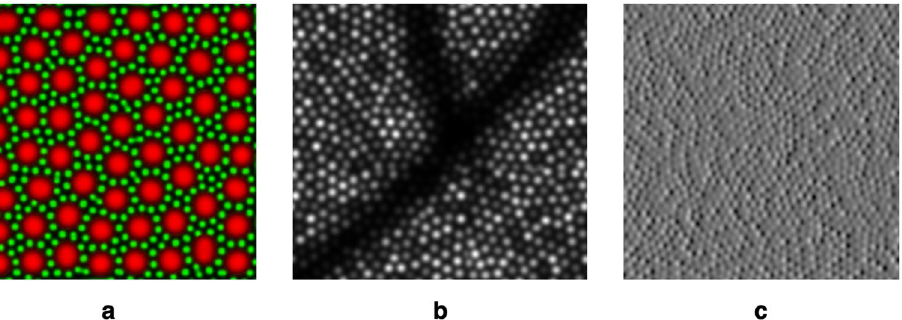
Figure 5. Examples to show possible extensions to ERICA. Panel ( a ) shows the output of a reaction-diffusion model that includes a rod mosaic (shown in green), self-organising itself between cone cells (shown in red). Panel ( b ) shows simulation of the shadow caused by a retinal blood vessel overlaid on a synthetic cone mosaic image. Panel ( c ) shows the approximation of a split-detection image, formed by reproducing the intensity profile of a photoreceptor inner segment as it typically appears in such images. This is assumed to be a differential image of a mosaic of Gaussian